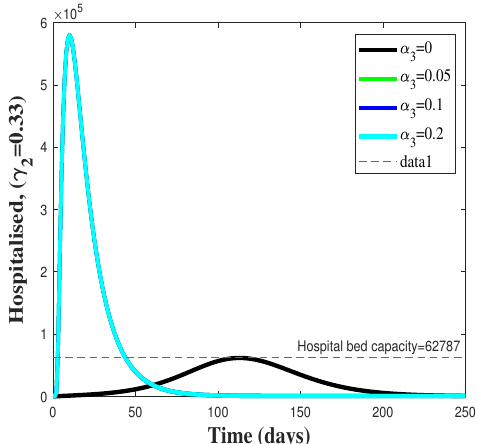
Fig. 14: Population level plots for hospitalized individuals for varying values of α